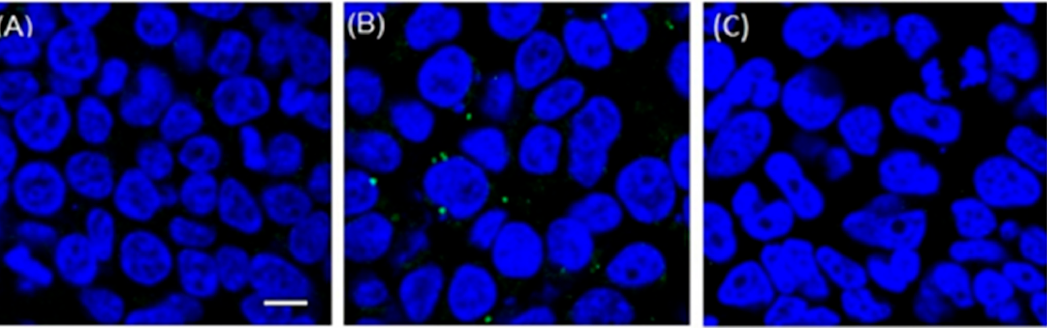
Figure 1. Compound 5 arrests D614G spike-pseudotyped virus entry. D614G spike-pseudotyped viruses were used to infect 293T-ACE2 cells, which were stained with DAPI (nuclear stain, blue) 2 h post infection. Size bar = 10 µm. Confocal microscopy images were acquired using a Nikon A1R confocal microscope with a 60×/1.4 NA oil-immersion Plan-Apochromat lens. ( A ) 293T-ACE2 cells were infected with D614G spike-pseudotyped virus; ( B ) experiment was performed in the presence of compound 5 at 5 µ M; ( C ) experiment was performed in the presence of chloroquine diphosphate at 5 µ M.